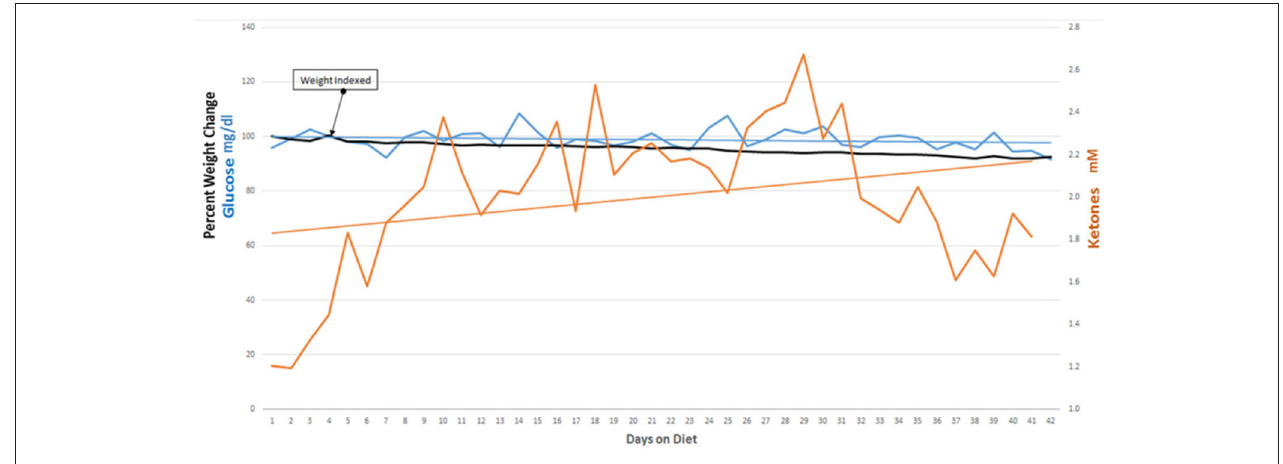
FIGURE 2 | Daily glucose and ketone averages and weight